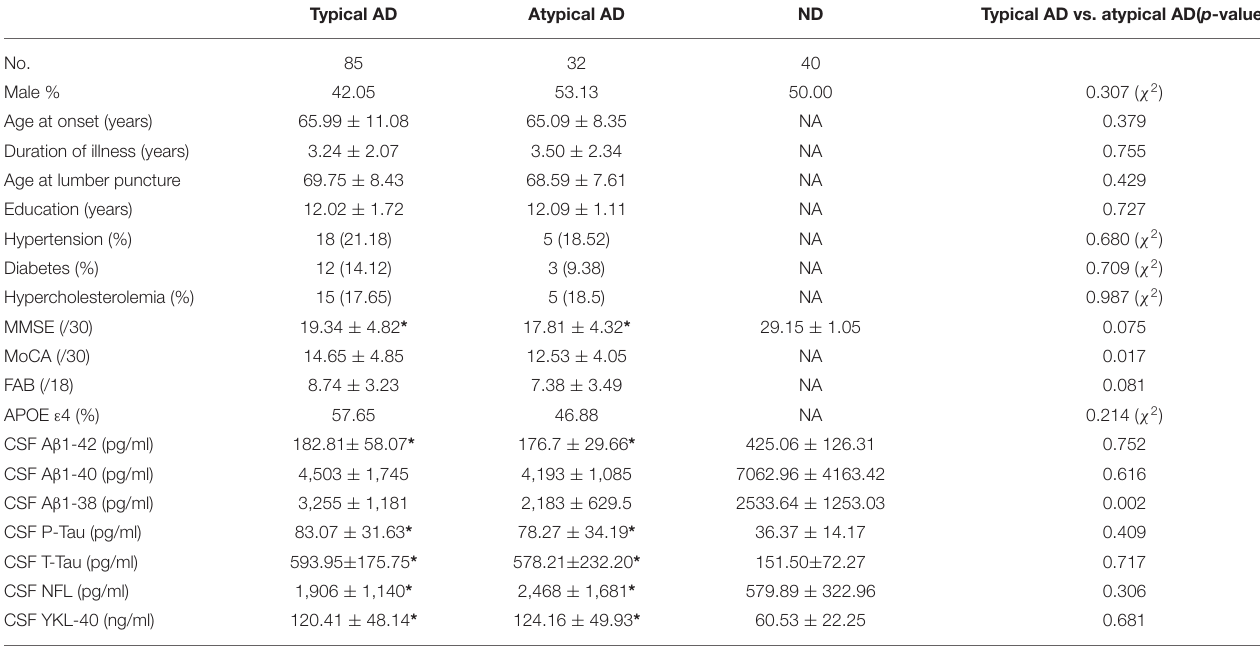
TABLE 1 | Demographics and CSF biomarkers in typical/atypical AD patients. Typical AD Atypical AD ND Typical AD vs. atypical AD( p